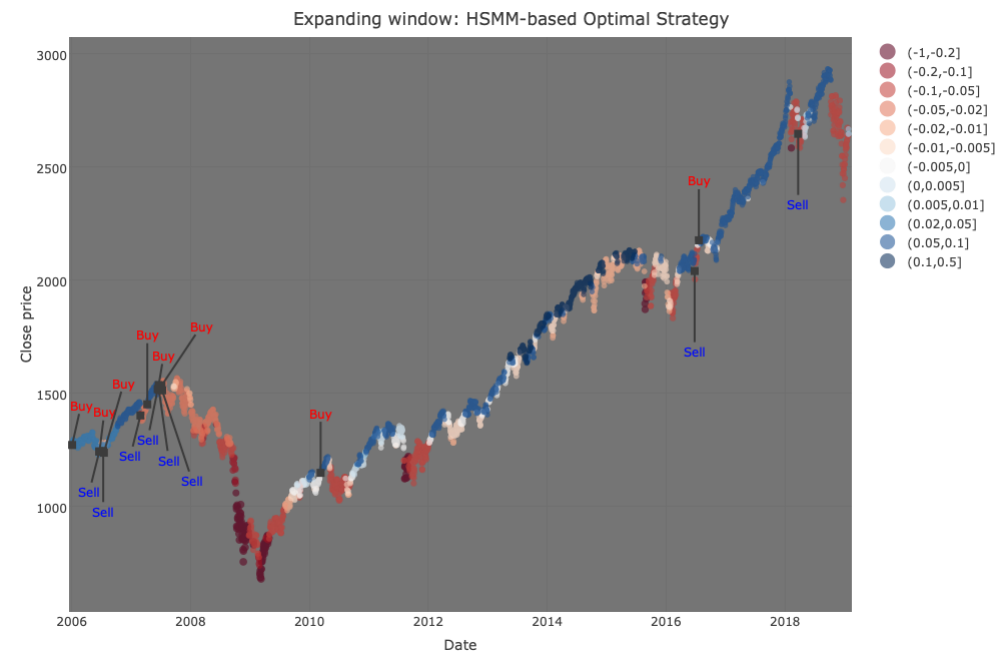
Figure 18. Best HSMM-based strategy for S and P 500 Index actions. Colours vary by the value of the state-dependent mean (see legend), and buy and sell signals are denoted in the